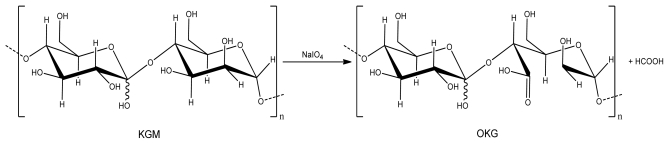
Oxidation reaction of konjac glucomannan (KGM) with NaIO4 to yield Oxidized Konjac Glucomannan (OKG).